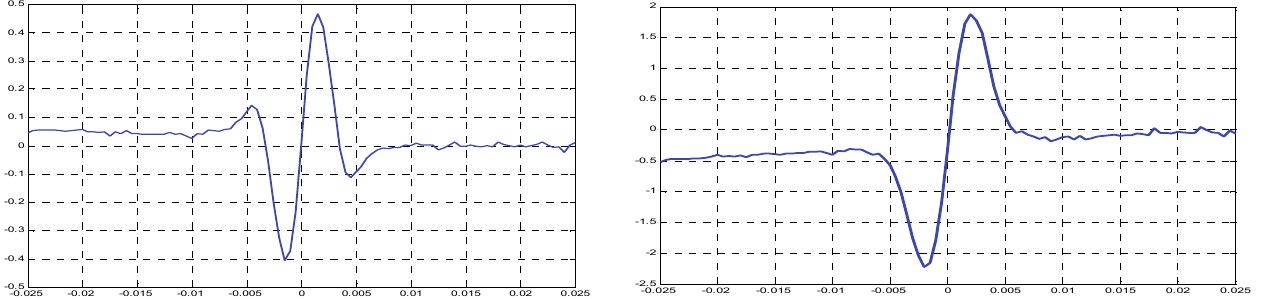
Figure 9: The imaginary part impedance Z ( Ω ). Figure 10: The real part impedance Z ( Ω